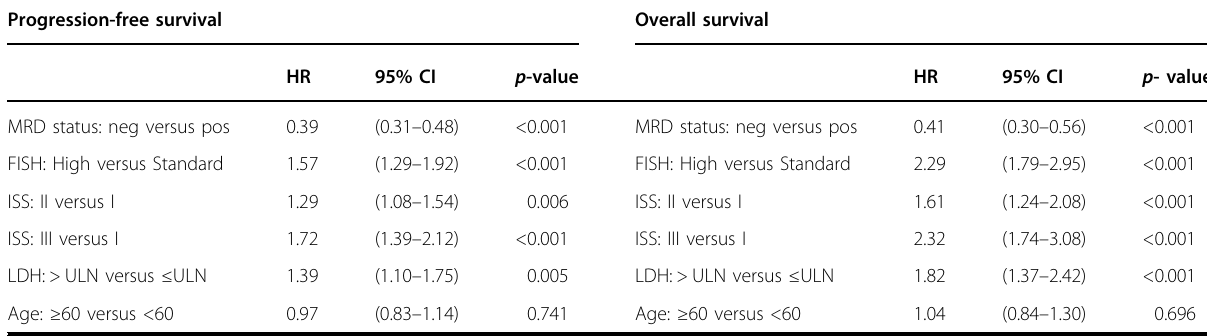
Table 2 Multivariate Cox analysis ITT. Progression-free survival